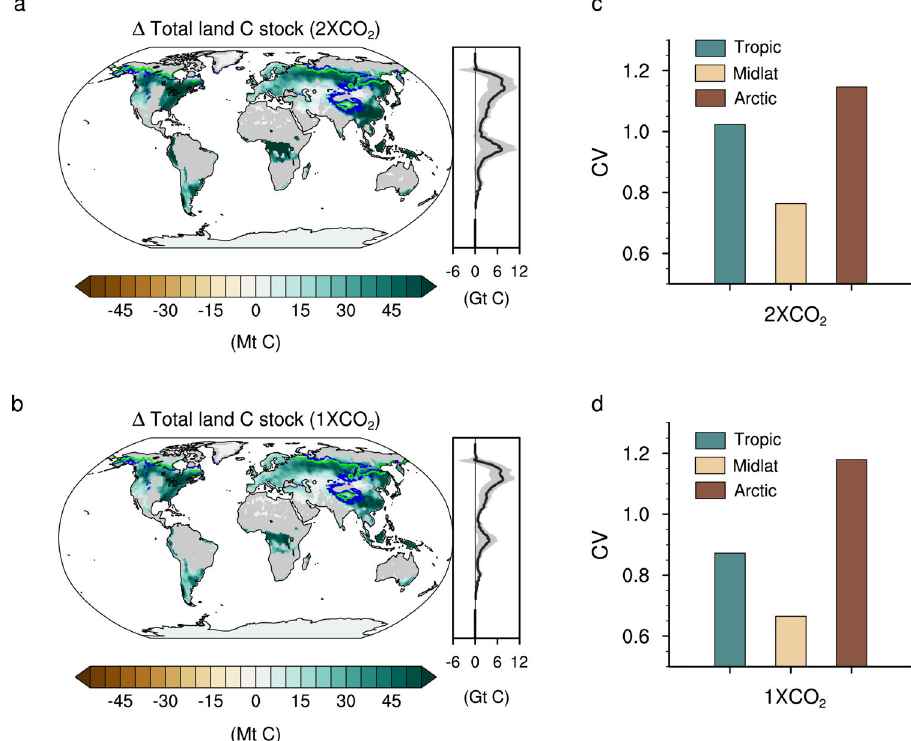
Fig. 3 Lagged response of terrestrial carbon cycle and its inter-model spread. a , b Difference of MME anomalies of total land C stock between model Year 210 and 70 (2 × CO 2 ) ( a ). MME anomalies of total land C stock at model Year 280 (1 × CO 2 ) ( b ). The zonal sum is plotted on the right side of the map. Only signi fi cant values at the 95% con fi dence level, based on the bootstrap method, are shown. The simulated MME permafrost extent and boundaries of continuous and discontinuous permafrost from the CCI-PF data (see “ Methods ” ) are superimposed in green and blue, respectively. c , d Coef fi cients of variation (CV: the standard deviation of the spread divided by the mean) of the difference in the total land C stock between model Year 210 and 70 (2 × CO 2 ) ( c ) and total land C stock anomalies at model Year 280 (1 × CO 2 ) ( d ) in the tropics (30°S – 30°N), mid-latitudes (30° – 60°N), and high-latitudes (above 60°N). All calculations were conducted after taking the 11-year running